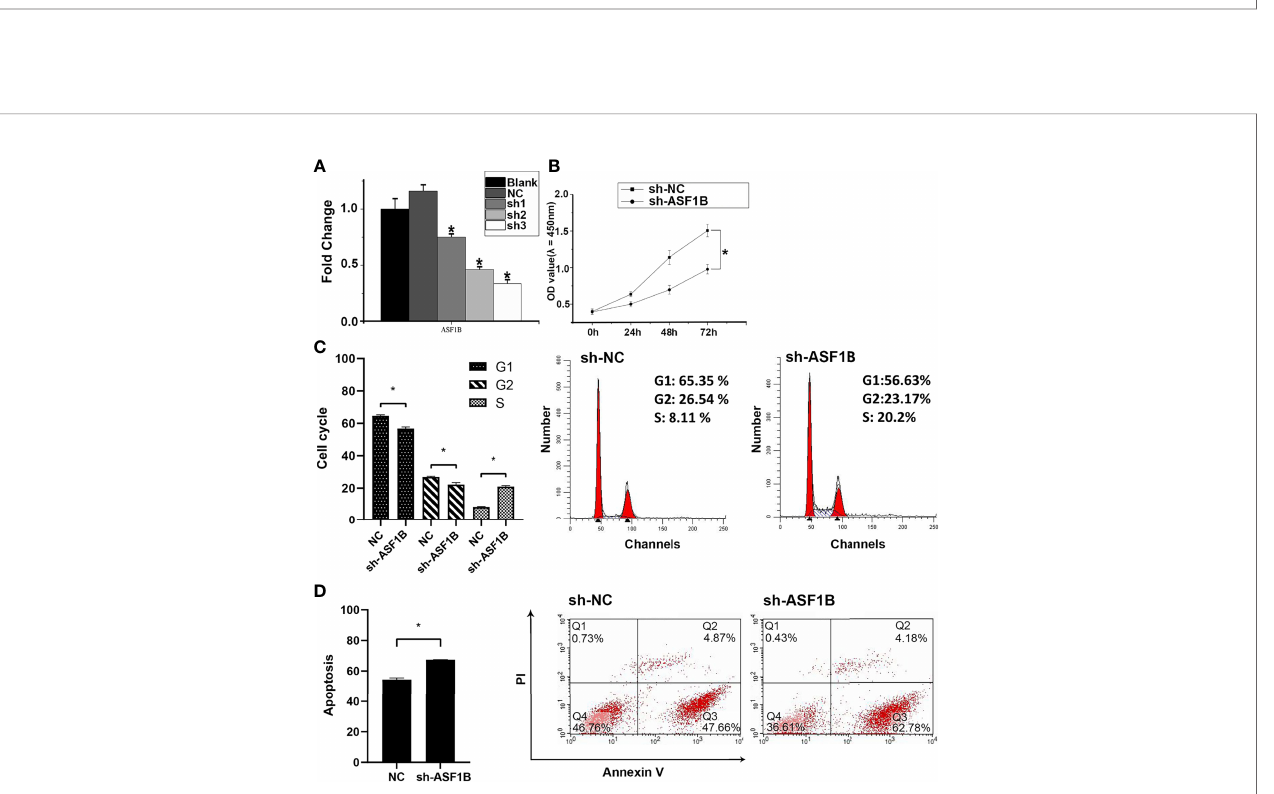
FIGURE 9 | Violin plot showing that ASFB1 expression was higher in male TC patient tumor tissues than in normal thyroid tissues (independent samples t-test, ****P<0.01).